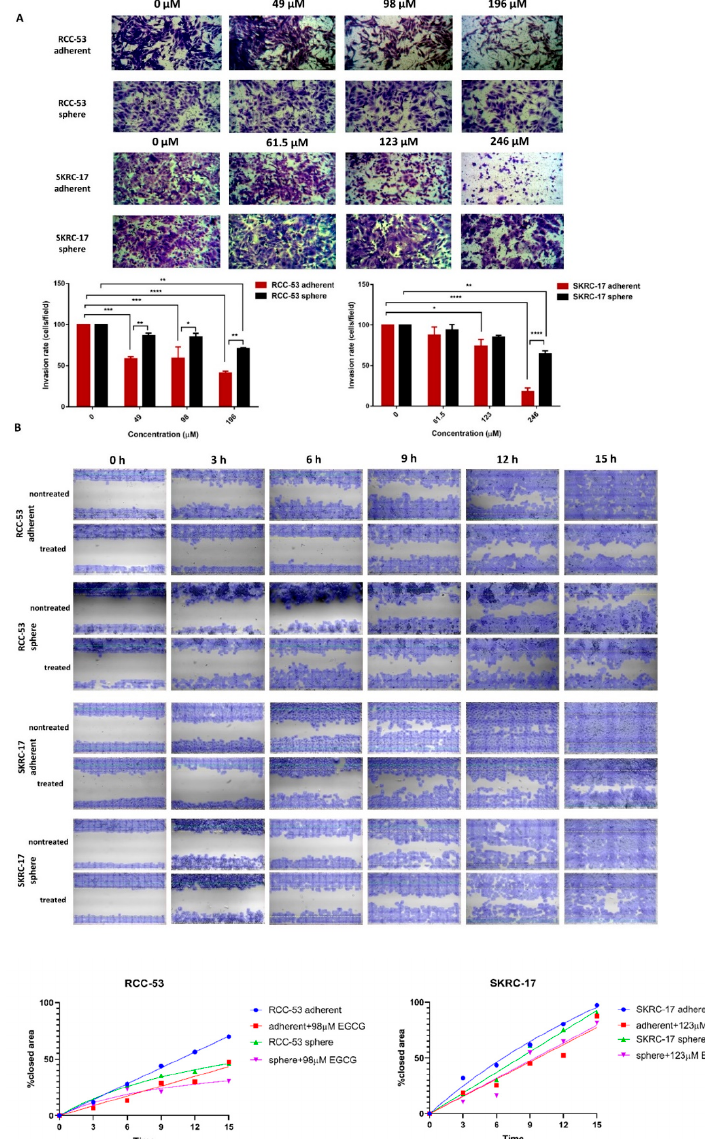
Figure 9. EGCG inhibited invasion and migration of the ccRCC cell lines and their corresponding CSCs. ( A ) For the invasion assay, the Boyden Chamber system was used with Transwell inserts in 24-well plates (8.0 µm pores), coated with growth factor reduced Matrigel Basement Matrix, from every insert a photo was taken at the magnification of 40× and the cells were counted (three fields per insert; Fiji ImageJ software). * p < 0.05, ** p < 0.01, *** p < 0.001, **** p < 0.0001. ( B ) For the scratch wound healing, assay plates with a cell-free gap of 500 µm were used (ibidi GmbH), photos were taken under the microscope at different time points at the magnification of 40× (Bresser GmbH DE-46414 Rhede Germany). EGCG in the 1 × IC50 group is shown, and the data were analyzed with the web-based Automated Cellular Analysis System (ACAS, MetaV ì Labs) using FastTrack AI image analysis